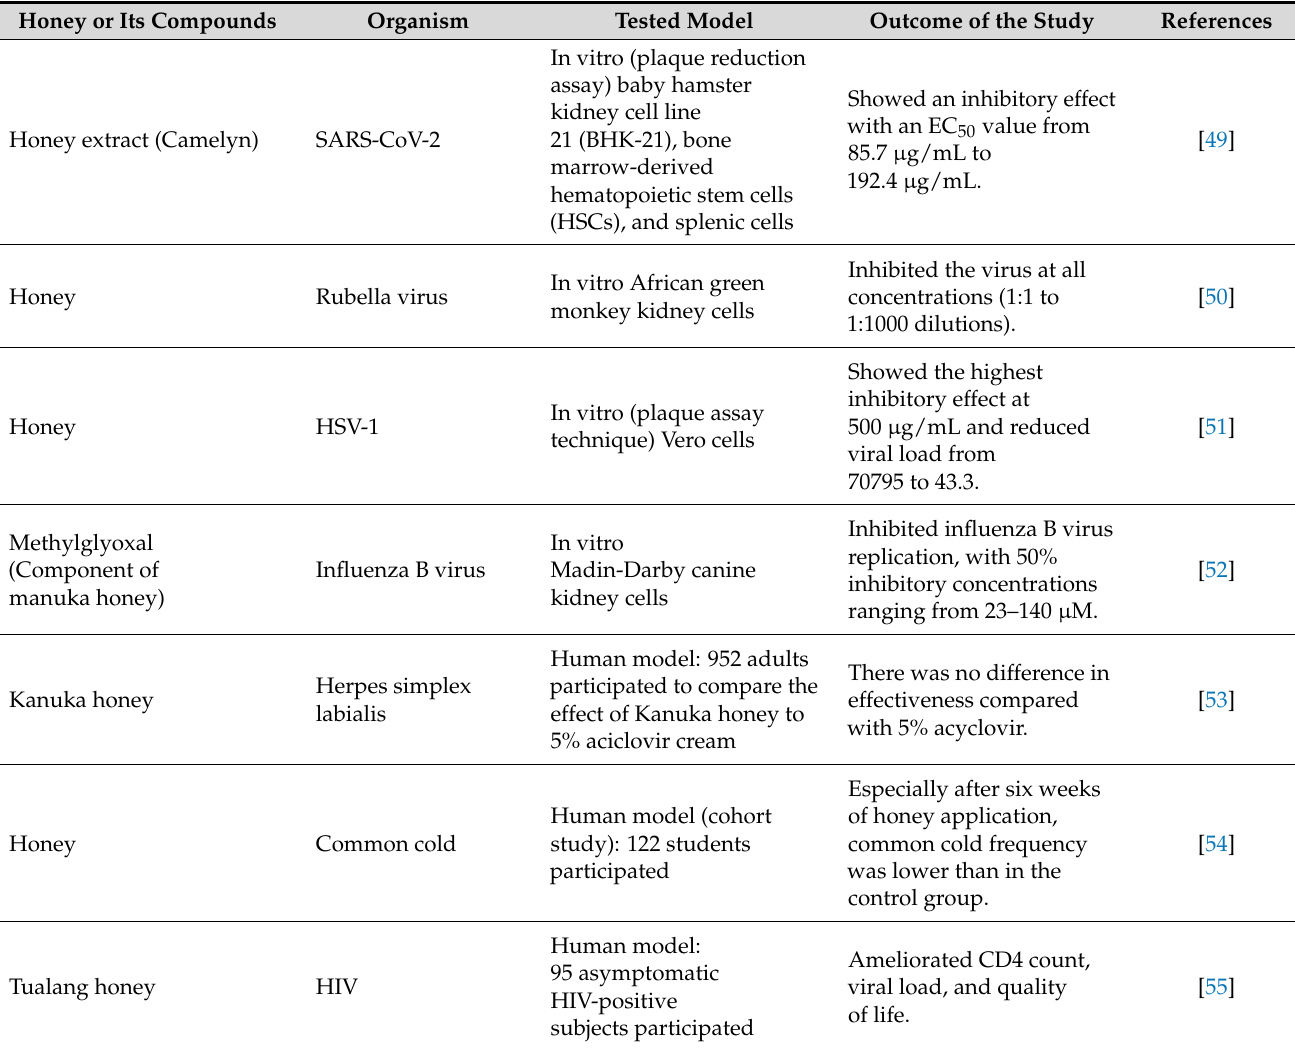
Table 1. Antiviral activities of honey and its